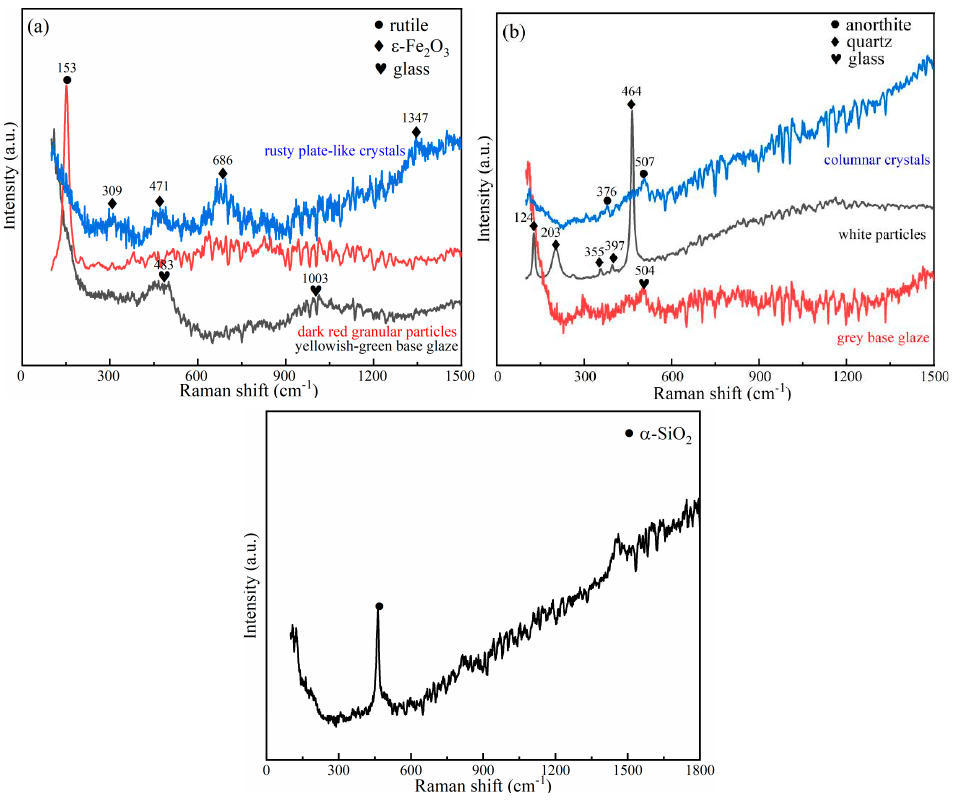
Figure 5. Raman spectra collected at different regions on glaze surfaces of the three samples: ( a ) JZ-07 tea-dust-glazed porcelain; ( b ) JZ-16 grey-glazed porcelain; and ( c ) JZ-14 pearl-glazed porcelain.